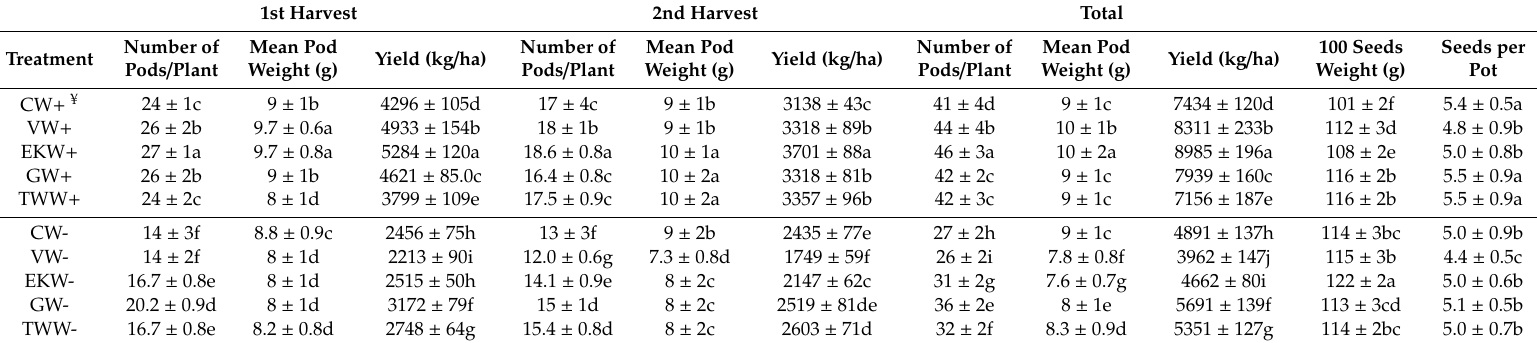
Table 2. Yield and growth characteristics of bean plants in relation to water stress and biostimulants application (mean ±